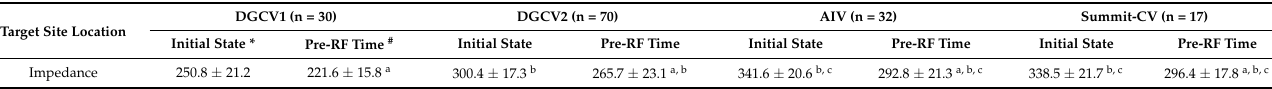
Table 1. The average impedance in different parts of TAODGCV at the initial state and the pre-RF time ( Ω , x ± S ).